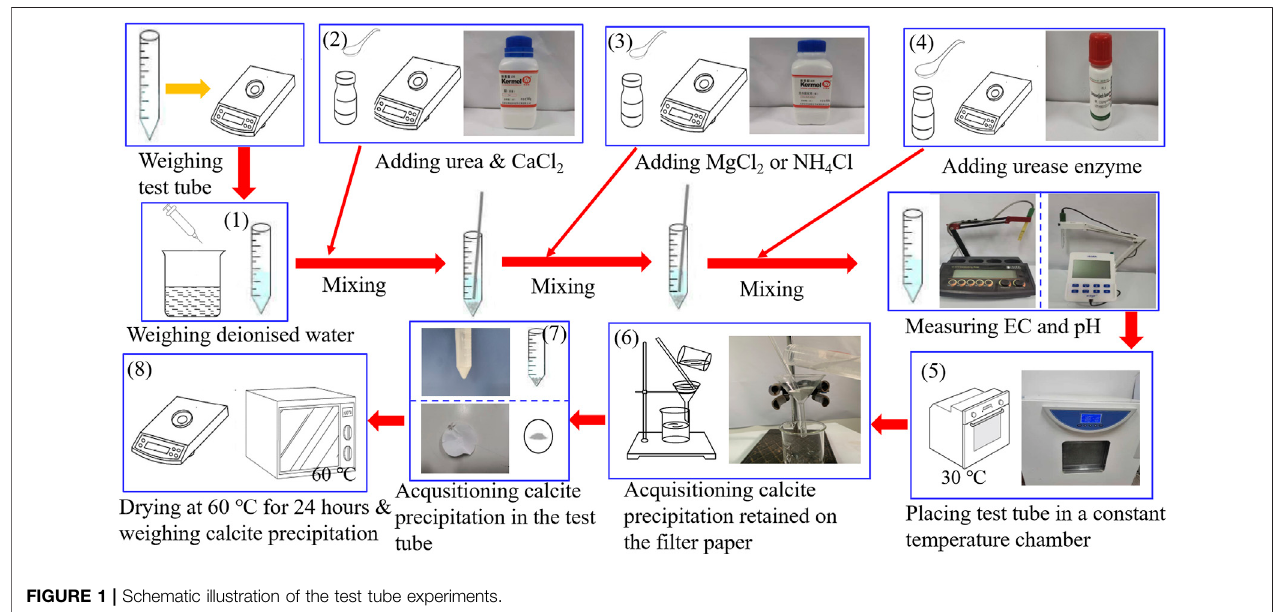
FIGURE 1 | Schematic illustration of the test tube experiments.